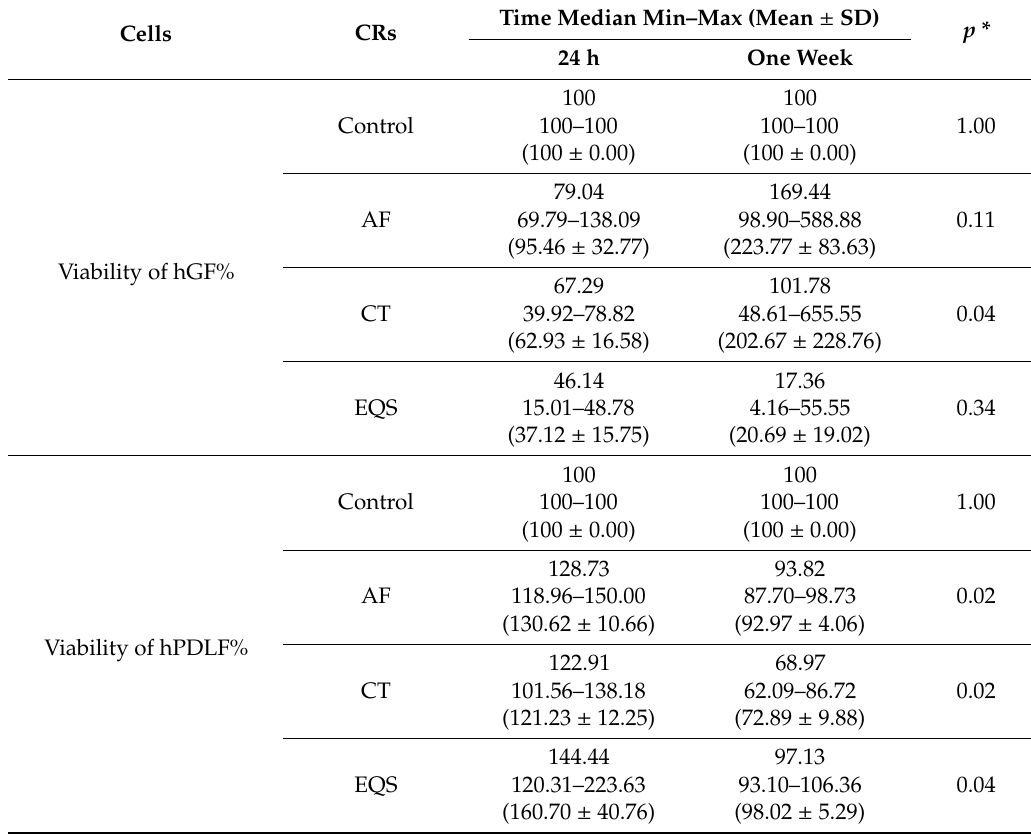
Figure 2. Cytotoxicity of CRs on hPDLF cells at 24 h and one-week time periods (mean ± SD). Accordingly, viabilities of hPDLF cells in contact with AF, CT, and EQS composite discs were lower at one week compared to 24 h (AF; p = 0.02, CT; p = 0.02, EQS; p = 0.04) (Table 4).